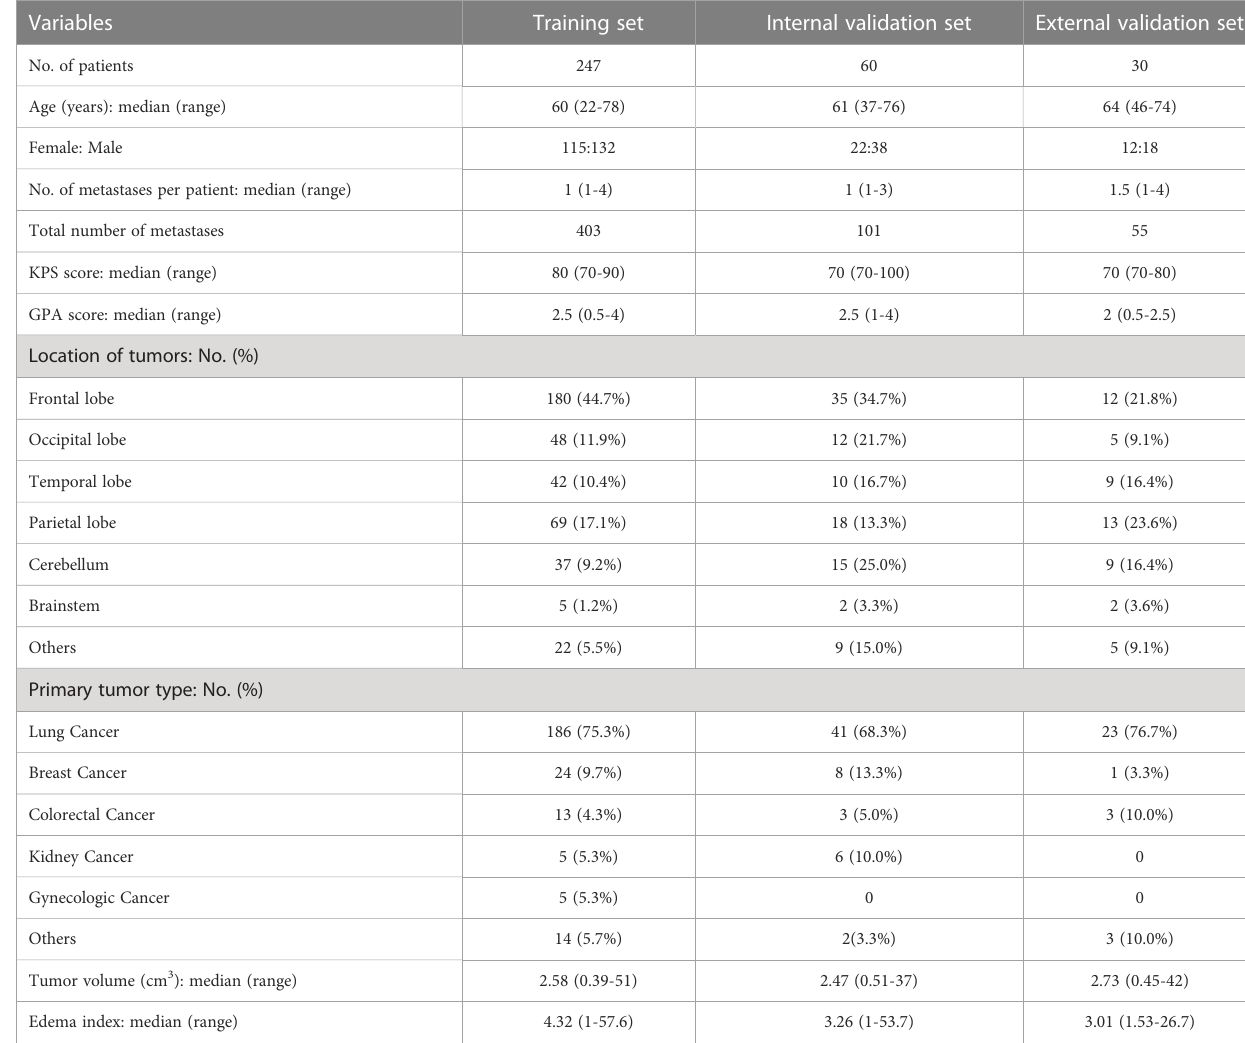
TABLE 1 Characteristics of patients and lesions in all datasets.